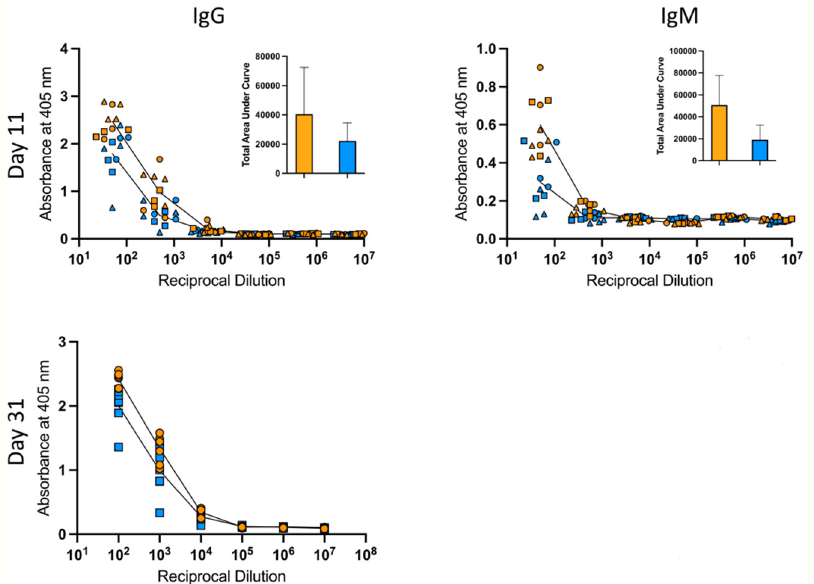
Figure 6. HA-B specific serum IgG and IgM responses. Mice were immunized subcutaneously with B/Malaysia HA protein in adjuvant, and serum was collected at days 11 and day 31 post-immunization. Serum samples from R-DOTAP (orange) and AddaVax + CpG (blue) were tested for IgG and IgM antibodies specific to recombinant HA B/Brisbane/60/08 by ELISA assay. Show are the dilution curves and each individual mouse (10 mice at D11 and 7 mice at D31). Shown in the inset are the total area under the curve calculations at D11. No differences between the R-DOTAP and AddaVax + CpG groups reached statistical significance.